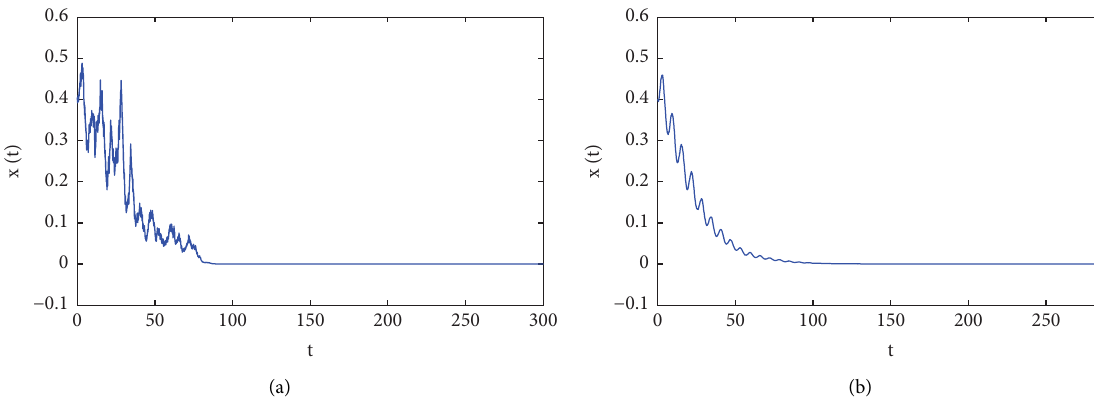
Figure 3: Te lines represent the solution of model (8) for r ( t ) � − 0 . 01 + 0 . 2sin t, K � 1, initial data x C � 0 , a ( t ) � 0 , σ ( t ) � 1 , c ( u ) � 0; (b) C � 0 , a ( t ) � 0 , σ ( t ) � 0 , c ( u ) � − 0 . 05.